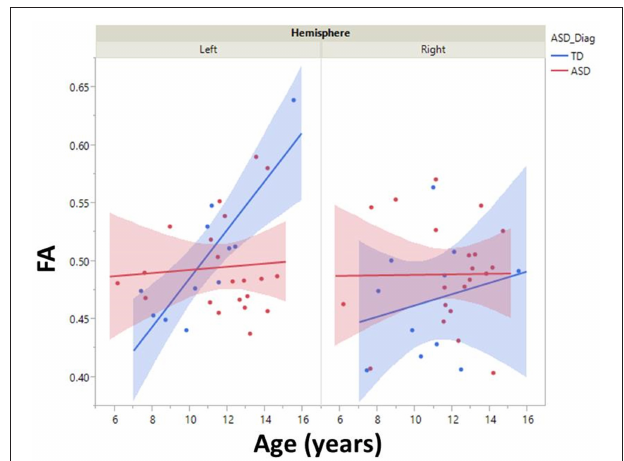
FIGURE 2 | Developmental trajectory of left and right auditory radiation microstructure are shown with 95% confidence intervals (shading). Left-hemisphere FA increased at a faster rate in the TD vs. ASD group ( p < 0.01 ). No right-hemisphere group difference in maturation was observed.